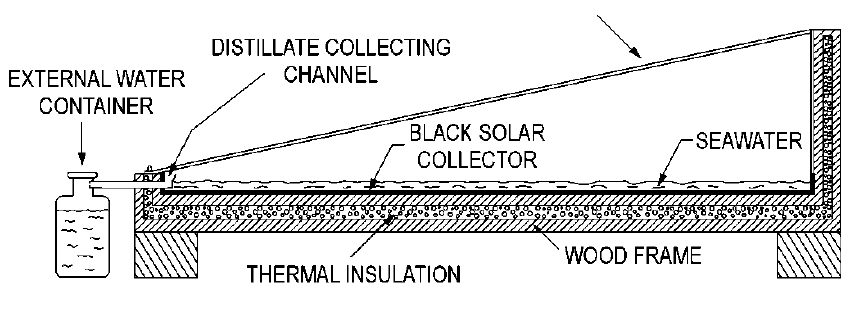
Figure 1. Single ‐ effect single ‐ slope condenser solar still.